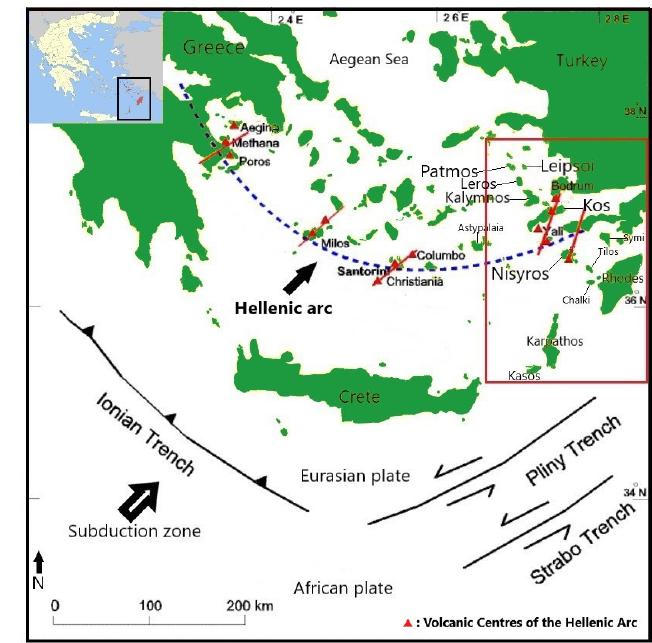
Figure 1. Location of the Dodecanese complex in the southeastern branch of the South Aegean Active Volcanic Arc, at the convergence limits of the two lithospheric plates, the Eurasian and the African.